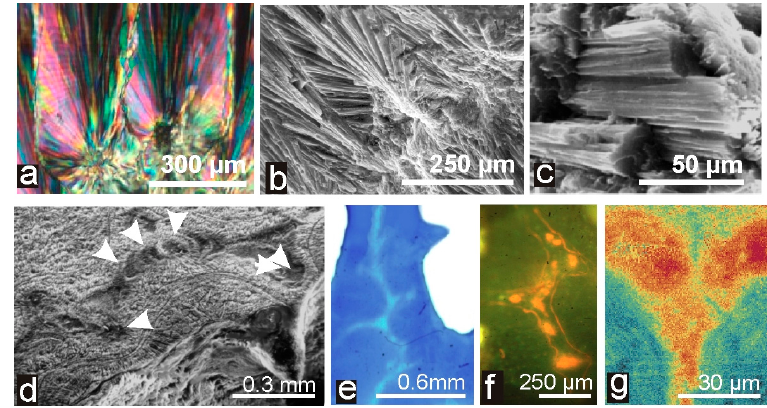
Figure 3. The crystal-like fibers and spherulitic crystallization of coral skeletons ( a , c ) and the biochemical evidence of an initial mineralization area with specific biochemical properties. ( a , b ) Thins section viewed in polarized light ( a ); and SEM picture of a fracture surface clearly support the concept of “spherulitic crystallization” of the fibers ( c ); ( d – g ) The initial mineralization area in Montasdrea ( d ) illustrates: the biochemical specificity by UV fluorescence ( e ); acridine orange staining ( f ); and XANES (X-ray Absorption Near Edge Structure) mapping of sulfated polysaccharides ( g ).